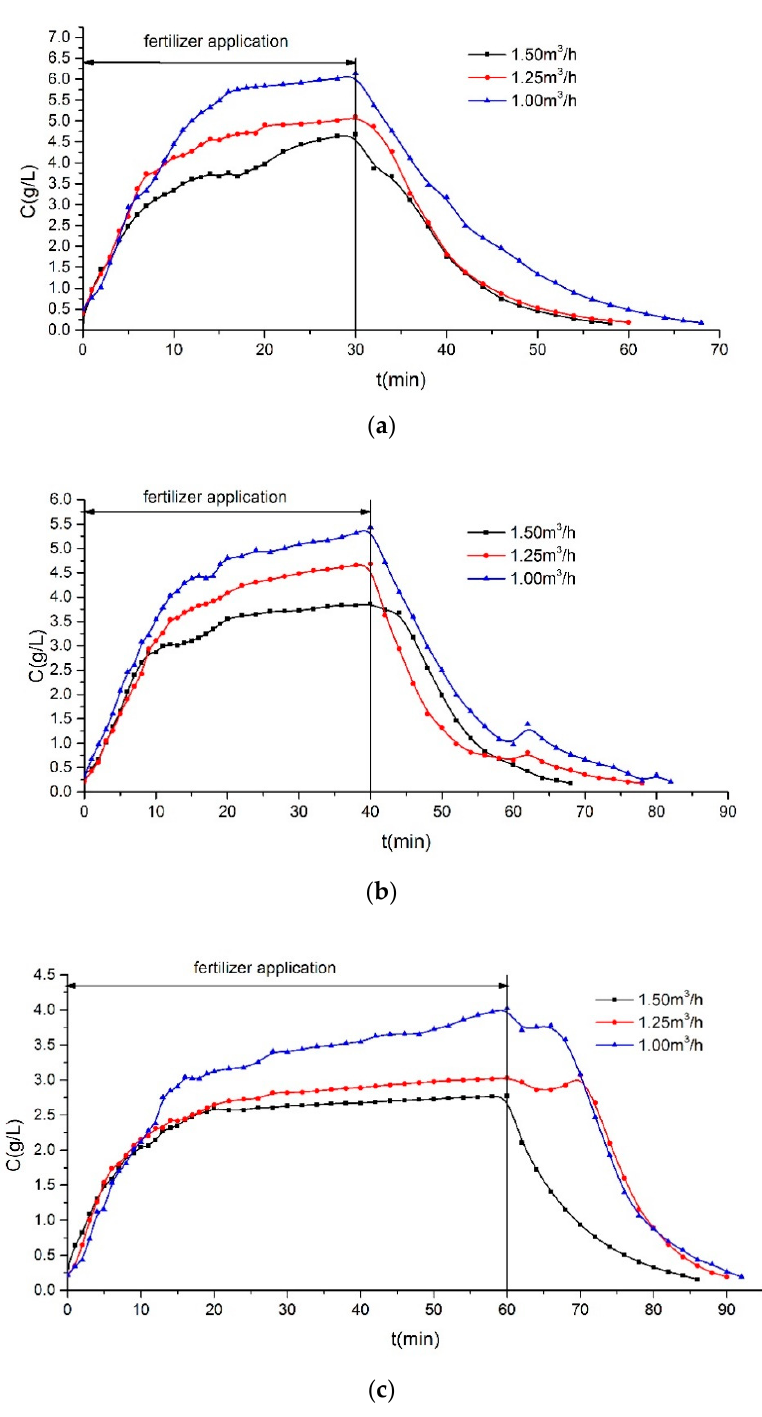
Figure 6. Variation of the fertilization concentration with time when the designed device applied 5 kg compound fertilizer. ( a ) T = 30 min, ( b )T = 40 min, ( c ) T = 60 min.